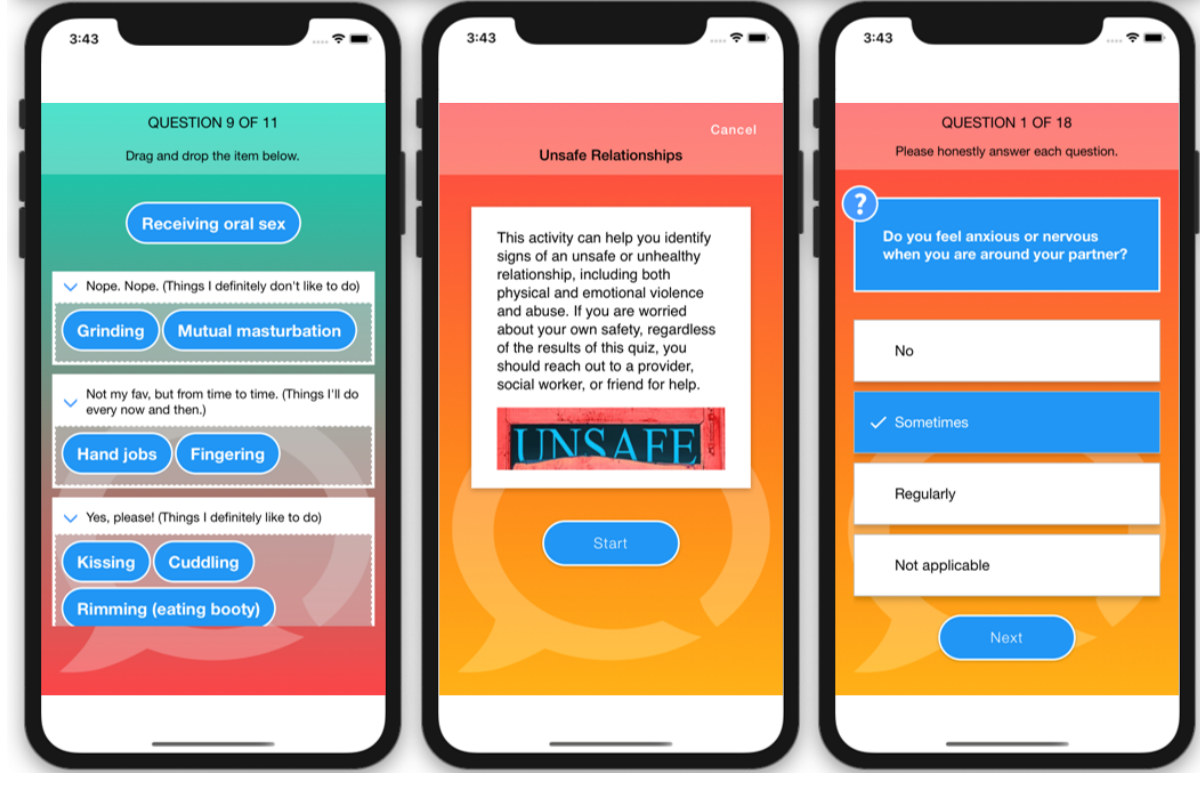
Figure 8. Example screenshots of decision-making activities in the HealthMpowerment (HMP) 2.0 intervention